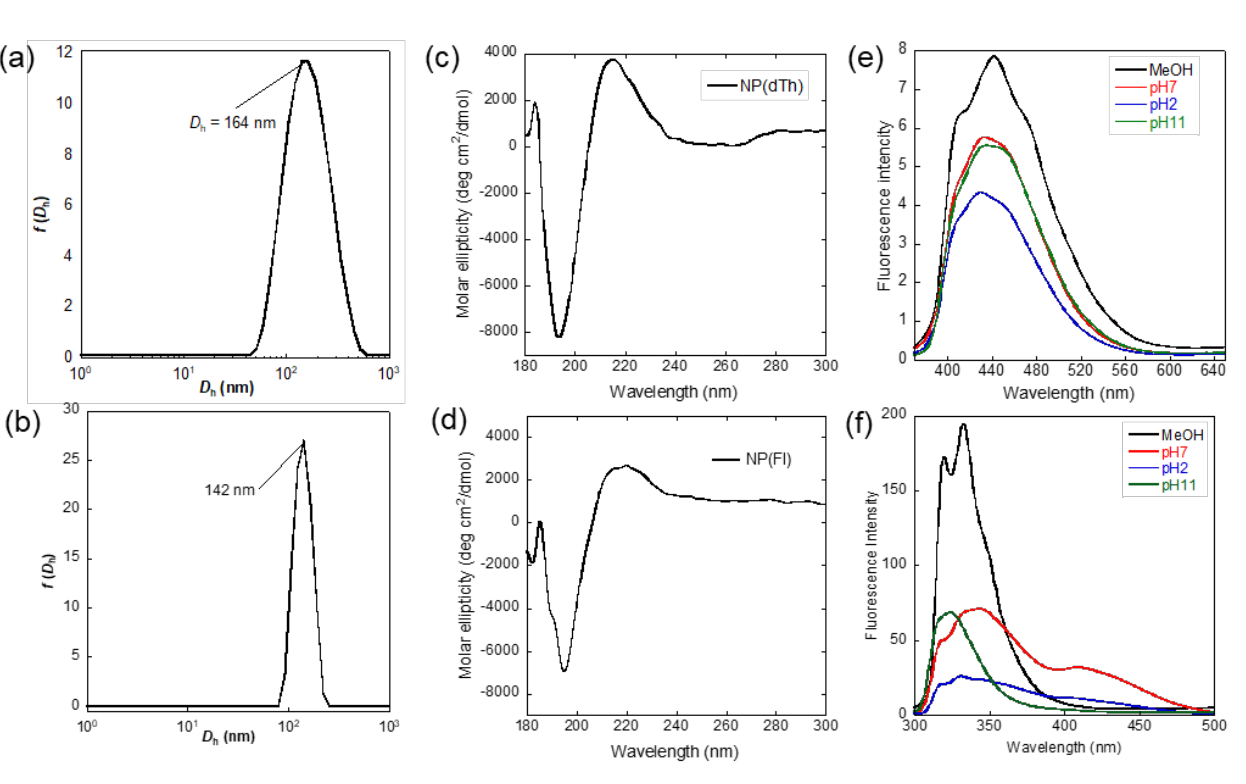
Table 1. Synthesis and characteristics of NPs.